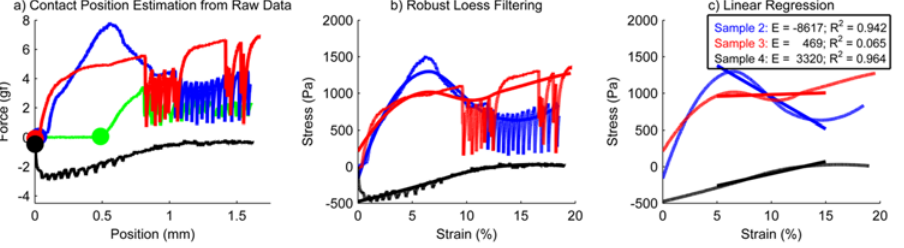
Fig 2. Analysis of compression data from four representative hydrogel samples. All data shown is 4 mg/ml, pH 8.4, 37°C. a) Identification of contact position, marked by a filled circle. b) Robust loess smoothing. c) Linear regression of smoothed data from 5 – 15% strain. Sample 1 (green) is discarded after step (a) because the sample thickness, determined from the contact position, is 6.9% (585 μ m) less than the nominal thickness. Sample 2 (blue) is discarded after step (c) because E = -8617 Pa < 0. Sample 3 (red) is also discarded after step (c) because the regression R 2 = 0.065 < 0.5. Sample 4 (black) is considered valid and returns a compression modulus of 3320 Pa which contributes to the mean compression modulus calculated for this fabrication